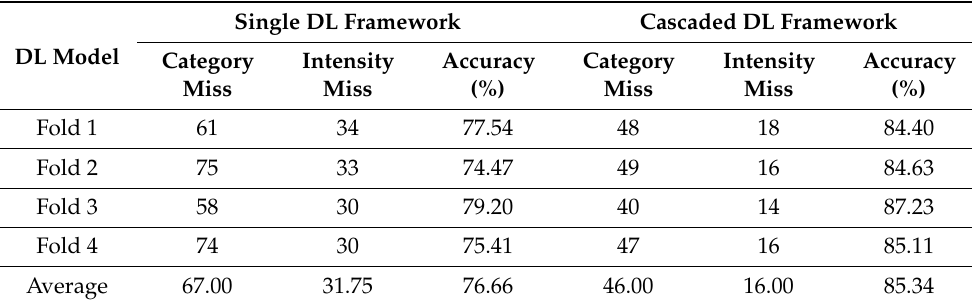
Table 5. The 4-fold cross-validation performance (i.e., test set accuracy) comparison between the Single DL and Cascaded DL